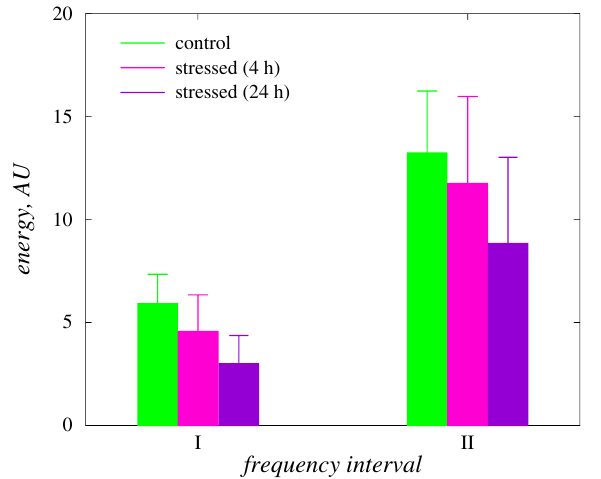
Fig. 6. Spectra of the H €o lder exponents showing a reduction of complexity of CVBF-dynamics in a rat with ICH compared with a healthy